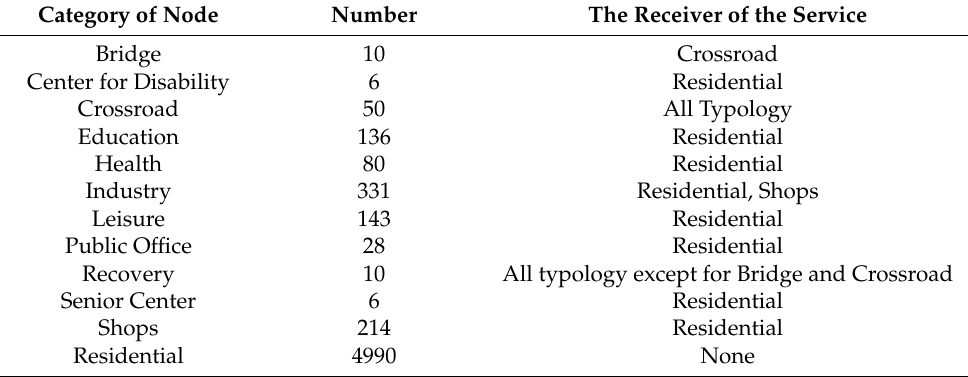
Table 2. List of node